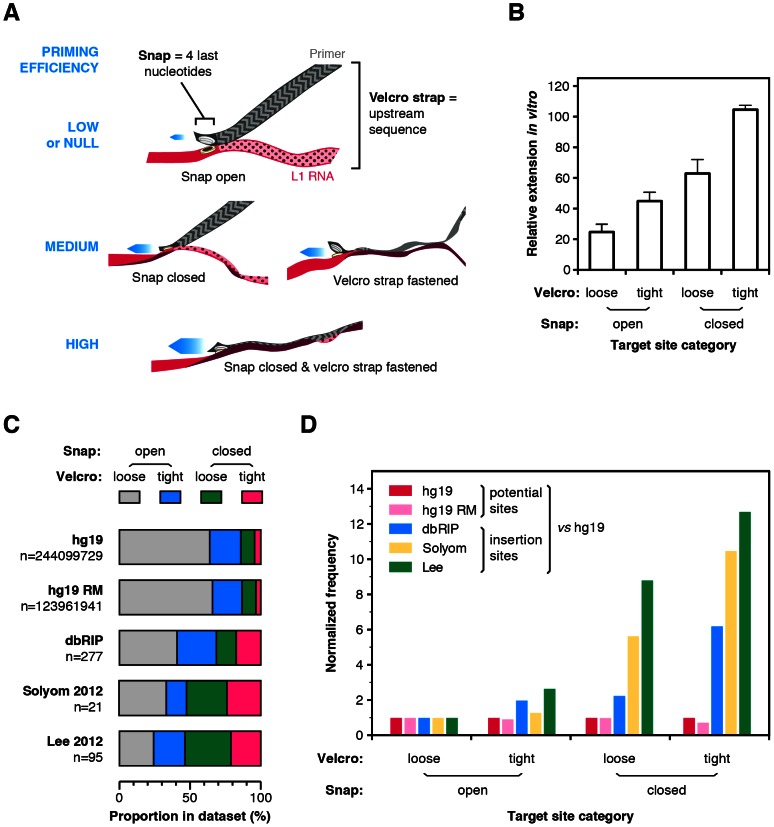
The snap-velcro model and supporting biochemical and genomic evidence.(A) A snap-velcro model for priming of L1 reverse transcription. The snap represents the 4 last nucleotides of the primer. It is considered as closed if it ends with 4 Ts (perfect terminal match) and as open if it contains a mismatch in the last 4 Ts. The velcro represents the 6 upstream bases. It is considered as tightly fastened only if the position-weighted T-score of this region is at least 50% of the maximum score. Otherwise, it is considered as loosely or not fastened. When the snap is closed and the velcro is tightly fastened, reverse transcription is high (bottom). If the snap is open or if the velcro is loosely fastened, reverse transcription priming is reduced (middle). Finally, if the snap is open and the velcro loosely fastened, reverse transcription priming is low or null (top). (B) In vitro efficiency of reverse transcription priming by the hL1 RNP depending of the snap and velcro status. Bars indicate the mean and error bars the S.E.M. Data are from Figure 4A, white bars excluded (see legend Figure 4). Both snap and velcro contribute extremely significantly to the differences of extension between primers (p<0.0001, two-way ANOVA). (C) Proportion of sites in the snap and velcro categories for the human genome (hg19), the repeat-masked human genome (hg19 RM) and in polymorphic L1 insertion datasets (dbRIP, Solyom 2012 and Lee 2012). Note that the proportion of sites falling in each of the snap-velcro category is significantly different in the L1 insertion datasets (dbRIP, Solyom 2012 and Lee 2012) as compared to the proportions found in hg19 or repeatmasked hg19 (Chi-square test, two-tailed P<0.0001). (D) Human L1s preferentially insert into target sites with snap closed and velcro fastened. Potential (hg19 or hg19 RM) or real (dbRIP or Lee 2012) target sites with a recognizable EN target sequence were categorized based on their snap and velcro states. The frequency of each category for each dataset was calculated and divided by the frequency of the corresponding category in the reference genome hg19 (enrichment). For each dataset, enrichment was further normalized to the enrichment of the “open snap/loose velcro” category to evaluate the respective effect of the snap and/or velcro on L1 insertion site frequencies (normalized frequency). The raw data for panels C and D are compiled in Table S2.